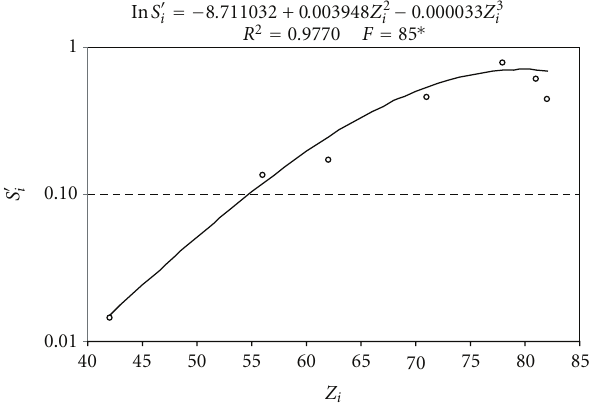
Figure 3: Experimental and calculated relative sensitivity for chemical elements emitting X-L rays for 42 ≤ Z i ≤ 82.